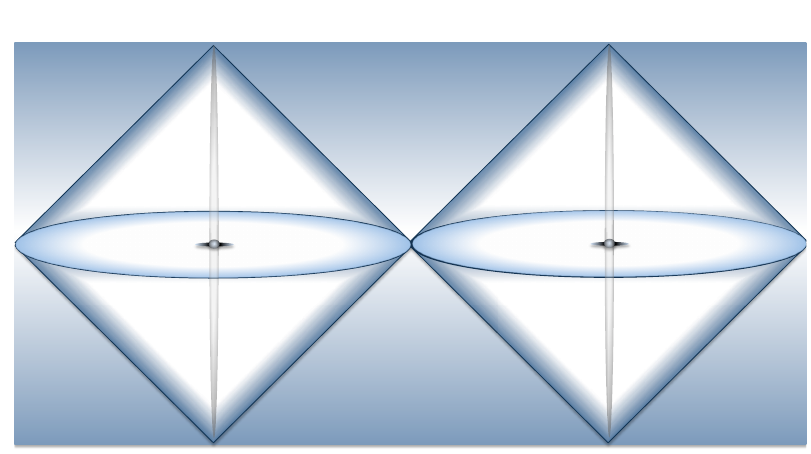
Figure 3: The Penrose diagram of global de Sitter space with a mass in the center of the static patch. The global solution requires that an equal mass is put at the anti-podal